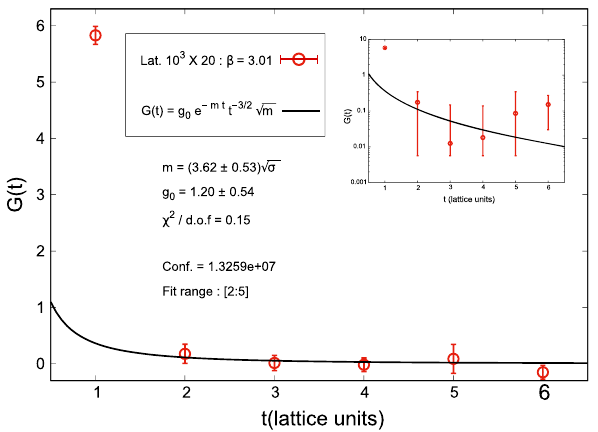
Fig. 9 Lattice estimation of correlation function G ( t ) . The curve in black is the fit of the lattice data to the asymptotic expression in Eq. (58) and for the fitting range t ∈ [ 2 , 5 ] . In the inset, G ( t ) in logarithm scale